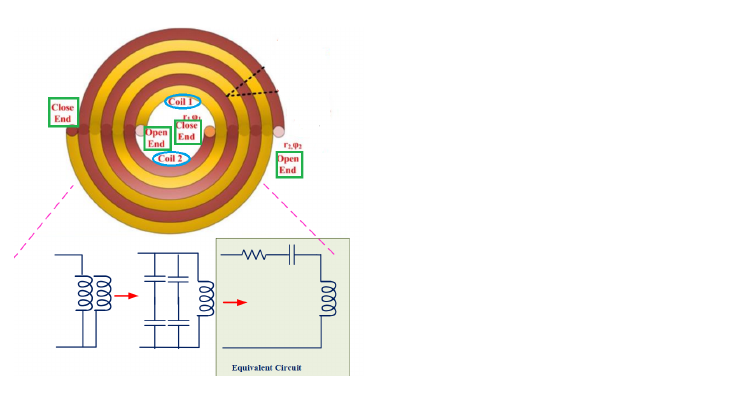
Figure 7. A WPT system with Bifilar coil with the equivalent circuit model.